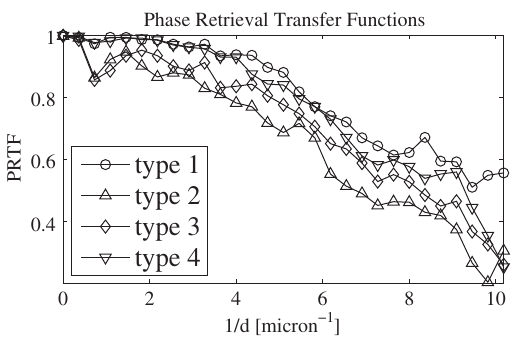
FIG. 9. Phase-retrieval transfer functions as a function of inverse resolution d − 1 , formed from the 250 patterns that correlated best, on average, with the other 500 phasing